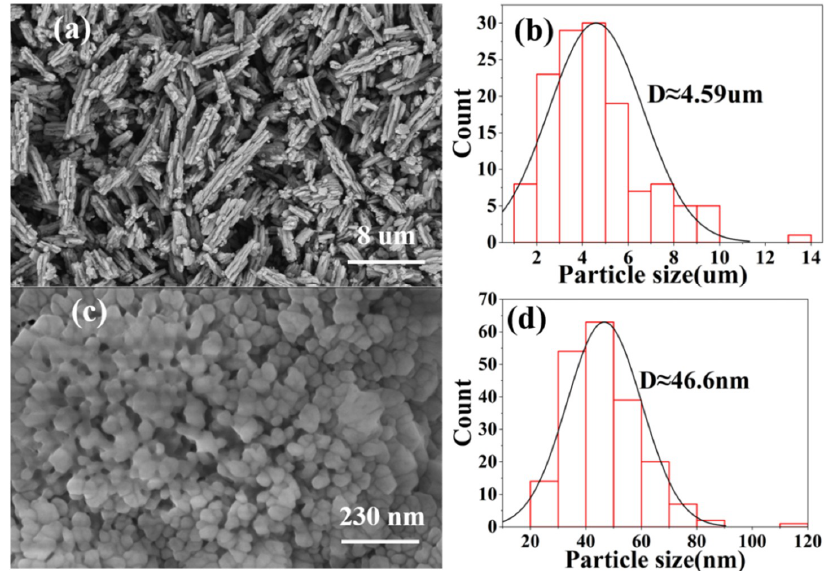
Figure 6. Morphology and grain size distribution of calcium carbonate powder samples, ( a ) is arag- onite, and ( b ) is the grain size distribution of aragonite, and ( c ) is vaterite, and ( d ) is the vaterite grain size distribution.